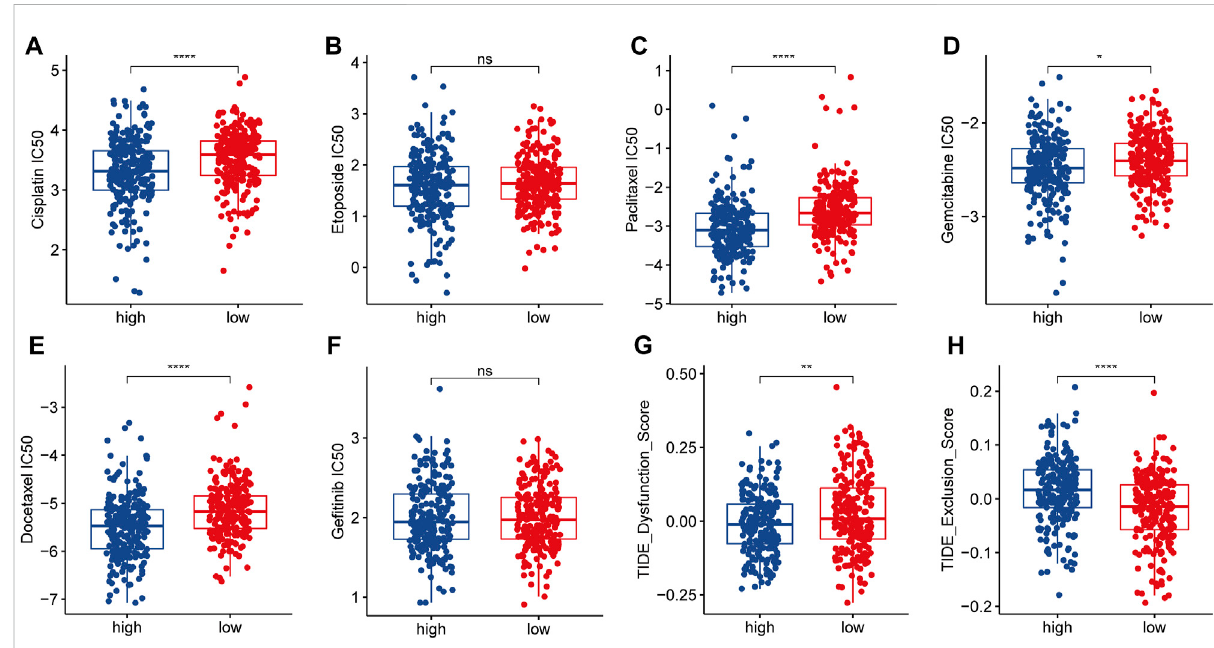
FIGURE 7 Response of two LRPI subgroups to antitumor therapies (A – F) Comparison of IC50 for different antitumor drugs (Cisplatin, Etoposide, Paclitaxel,Gemcitabine,Docetaxel,Ge fi tinib)intwoLRPIsubgroups (GandH) ComparisonofdysfunctionscoreandexclusionscoreinTIDEanalysis of two LRPI